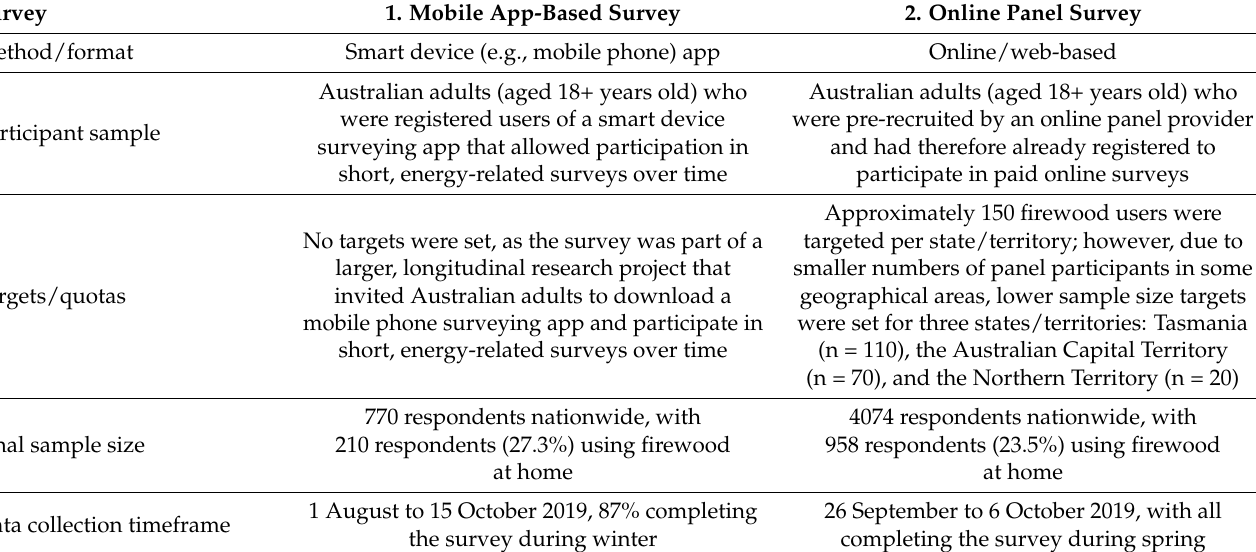
Table 1. Key features of the study’s two